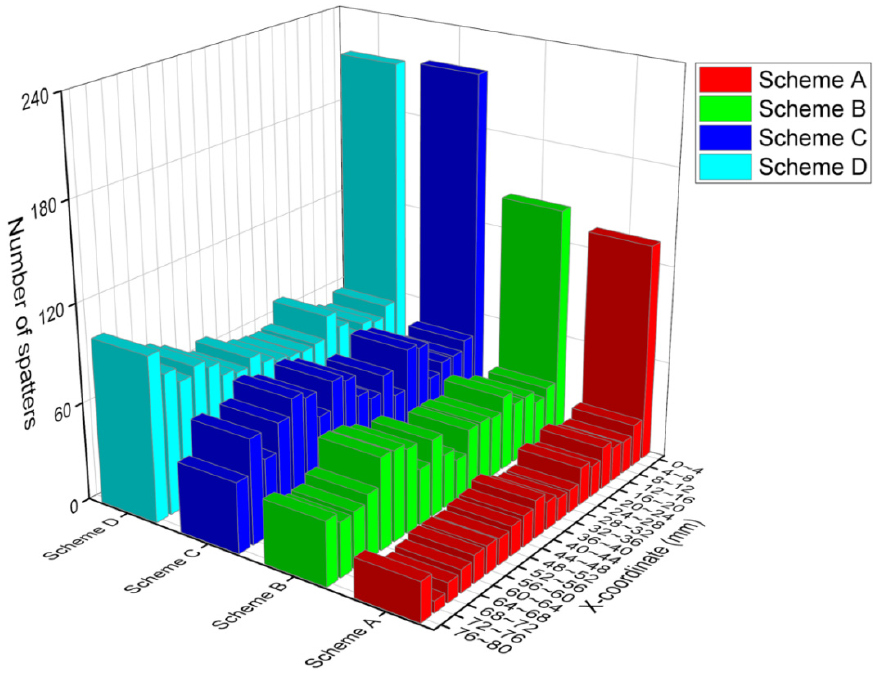
Figure 11. Distribution of the final drop locations of spatters in different simulation schemes.